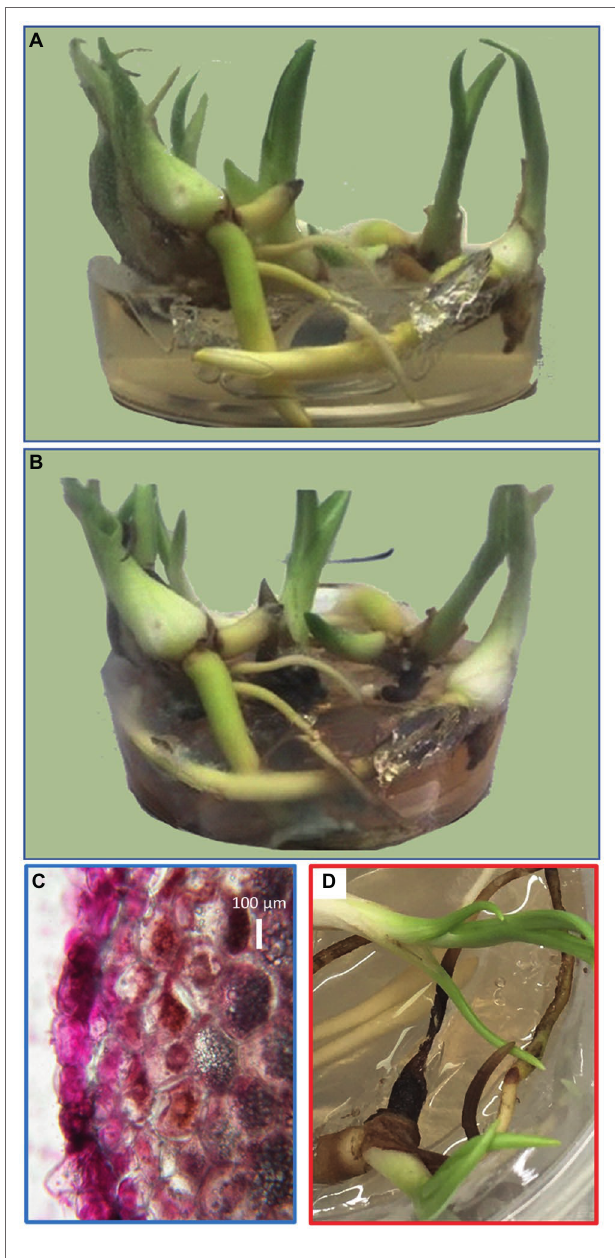
FIGURE 1 | Representative biological replicate of orchid tubers before fungal inoculation (A) and 12 weeks after inoculation and co-cultivation with Tulasnella calospora (B) . Cross section of an orchid root with the fuchsin- stained fungi at the time of tuber sampling showing the absence of symbiotic growth (C) and 2 weeks later showing visible symptoms of decay (D)